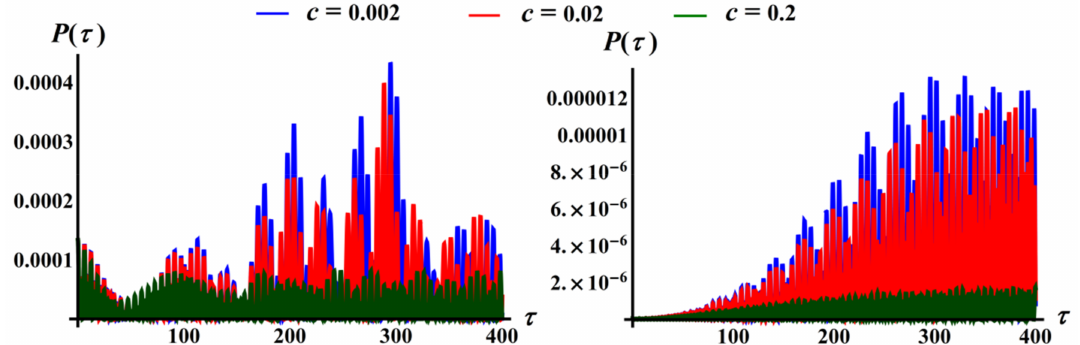
Figure 31. The time histories of the output power from the studied two energy-harvesting models with different selected values of damping